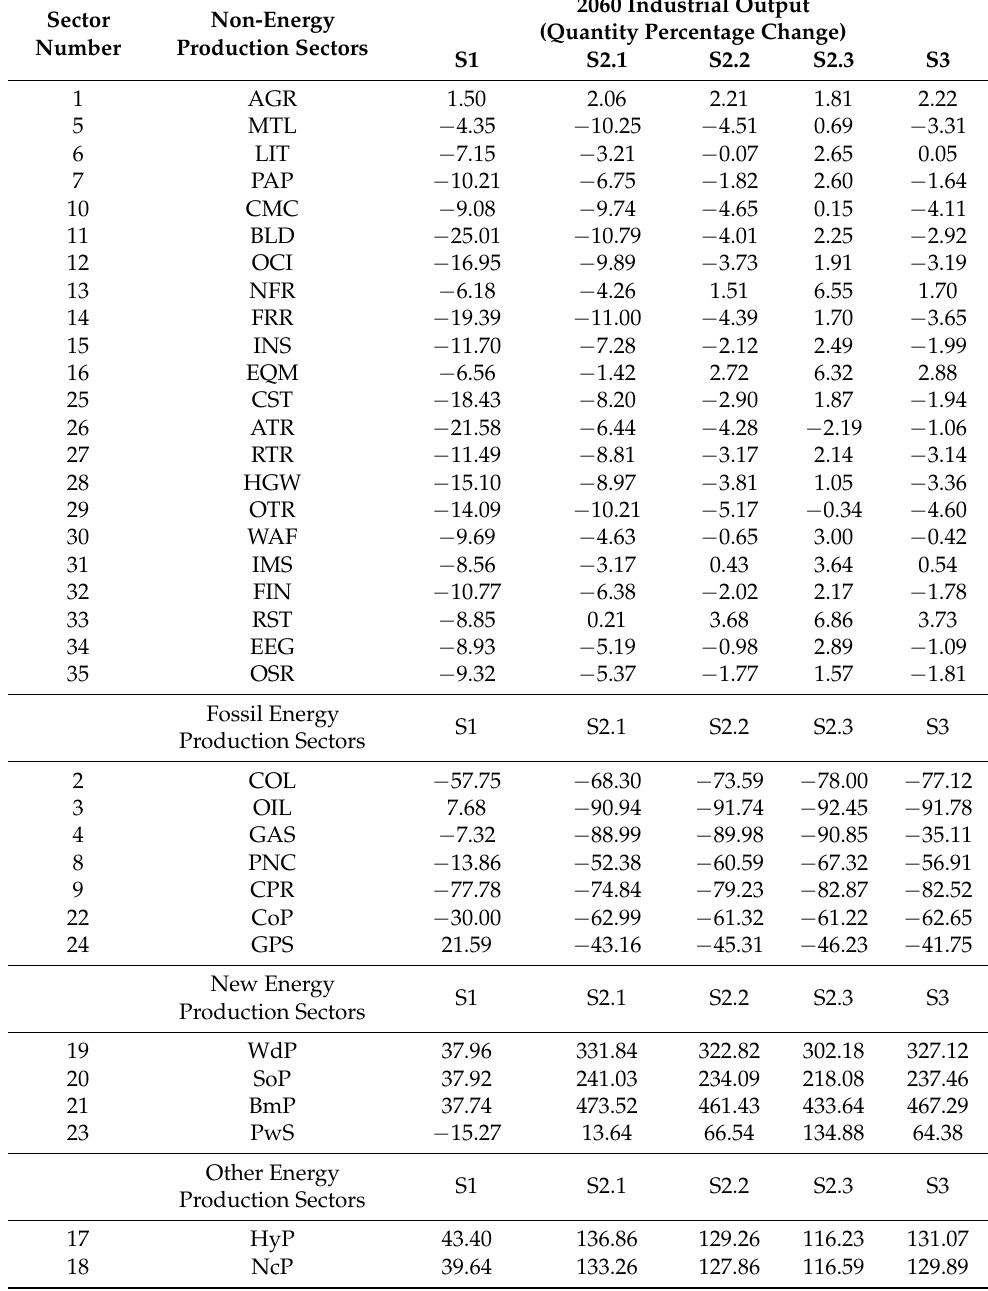
Table 4. Percentage change of industrial output and prices in 2060,